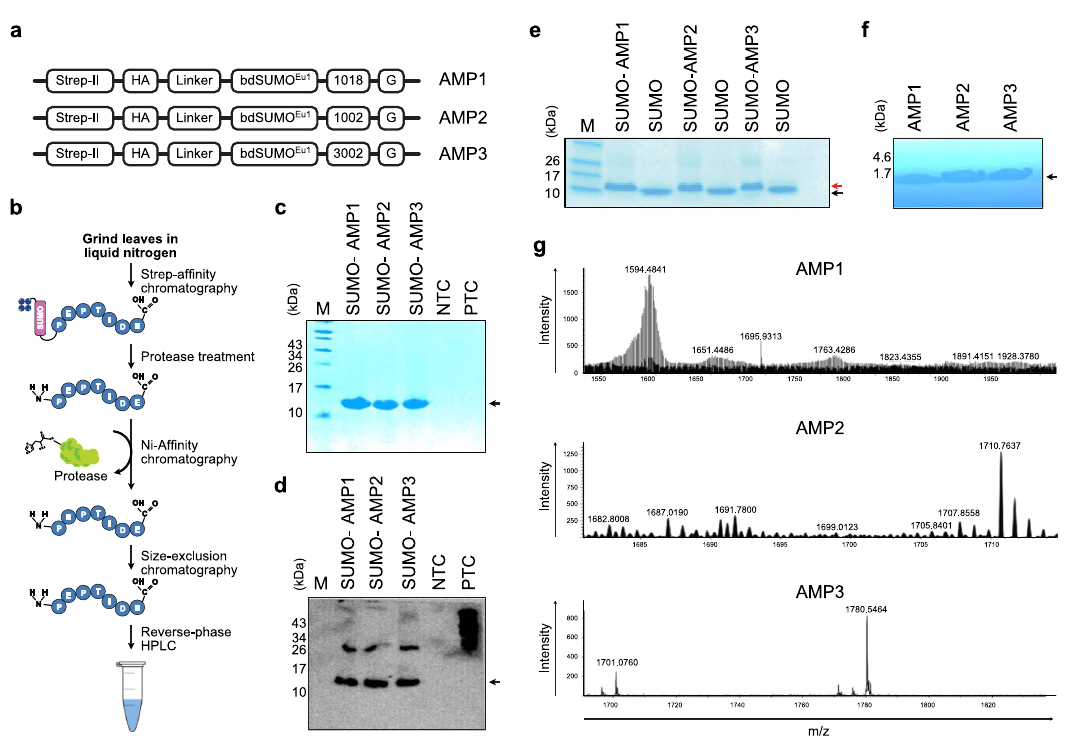
Fig. 1 | Establishment of a SynBio chassis for in planta expression of AMPs. withCoomassieBrilliant blue. d Immunoblotcon fi rmation of puri fi ed SUMO-fused AMPs. The separated proteins were transferred onto a polyvinylidene di fl uoride membrane and probed with a monoclonal anti-HA antibody for detection of bdSUMO Eu1 -AMPs ( ∼ 15.5kDa). Total proteins extracted from non-in fi ltrated leaves servingasnegativecontrol,NTC;HA-taggedproteinusedasapositivecontrol,PTC. Two independent blots were performed with similar results. Black arrowheads indicate the expected size of protein. e Gel shift assay for AMP release. Proteins were separated on a 18% Tricine-SDS gel to detect the release of AMPs peptide ( ∼ 1.5 – 1.7kDa) from the bdSUMOEu1 domain ( ∼ 14kDa). Red and black arrowheads indicatetheuncleavedandcleavedproteins,respectively. f RP-HPLCpuri fi cationof AMPs. Pooled fractions from SEC were separated on C8 column using acetonitrile gradient.Puri fi